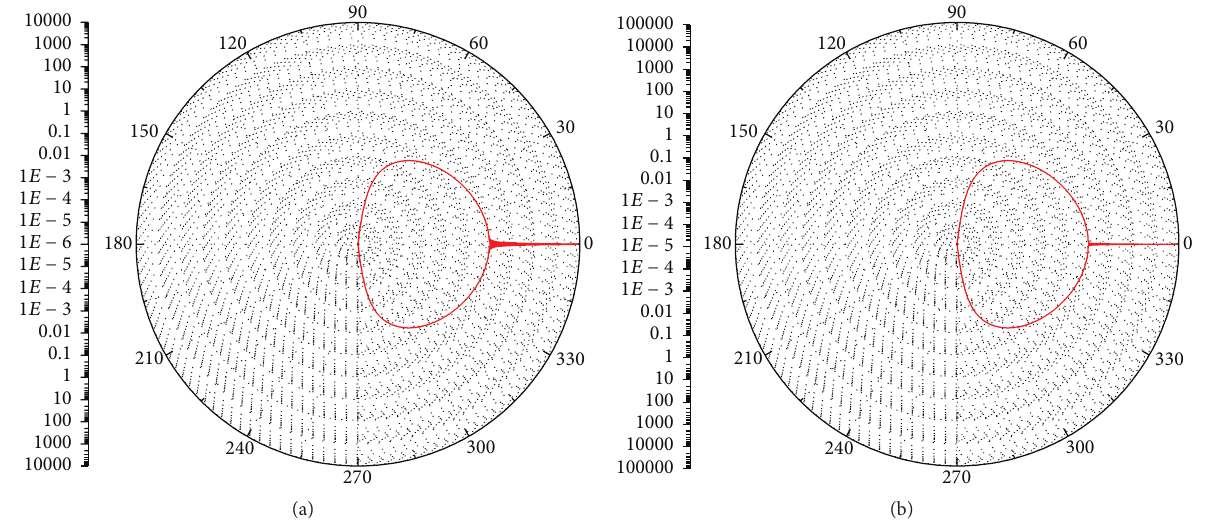
Figure 5: Optical scattering distribution by raindrops ((a) 𝑎 = 1.5 mm, 𝛽 = 0.8 ; (b) 𝑎 = 3.0 mm, 𝛽 = 0.8